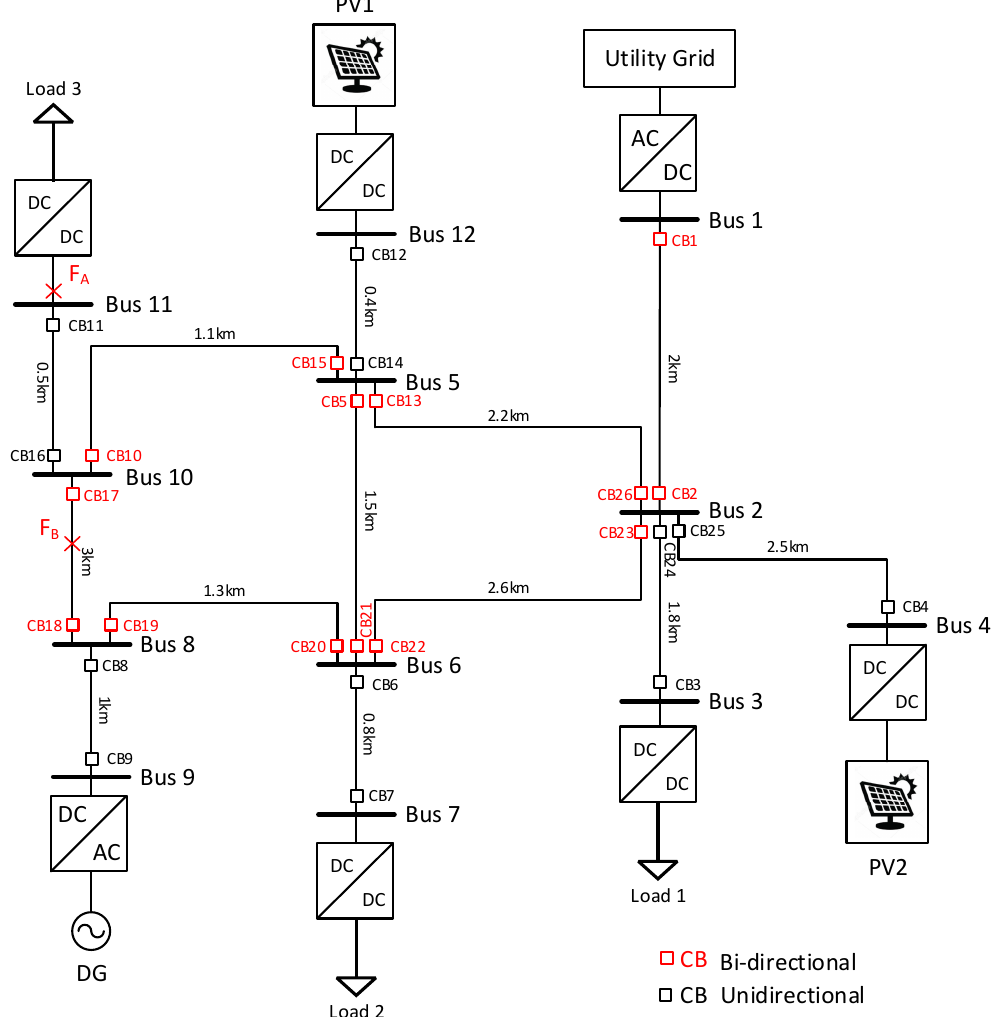
Figure 12. Medium-voltage DC ( MVDC) 12-bus micro-grid study case.